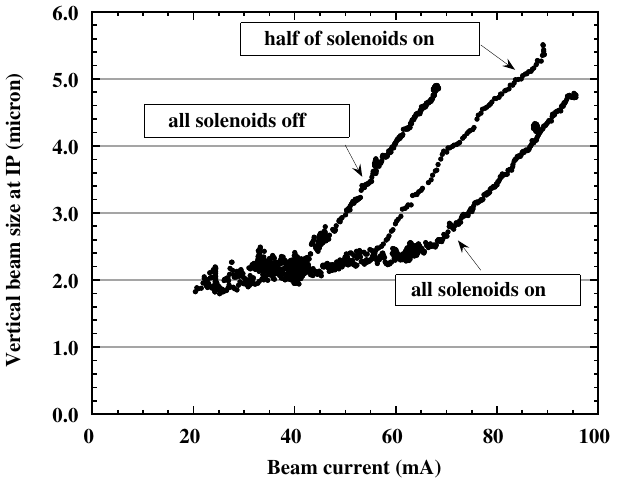
FIG. 14. (Color) Vertical beam size along a train followed by a test bunch in the KEKB LER, as observed by a synchrotron-light monitor with a gated camera, versus the bunch number [30]; the three curves refer to three different currents of the (last) test bunch, as is indicated in the legend.